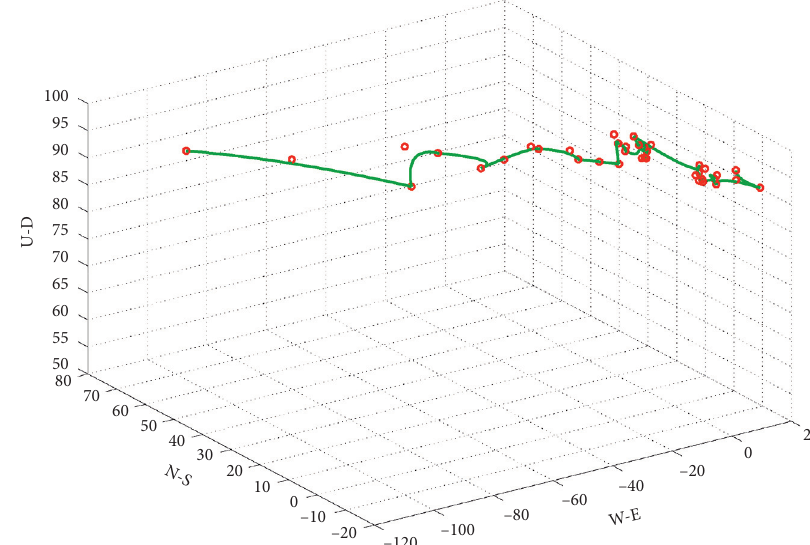
Figure 13: The 3D trajectory generated by the proposed ECOD